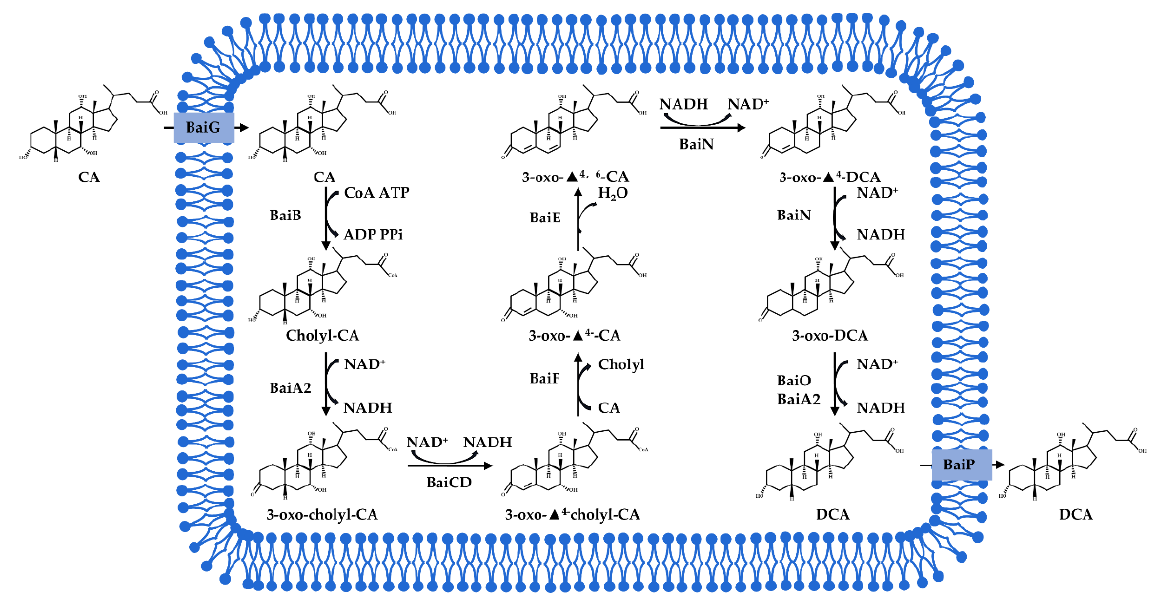
Figure 3. Biotransformation of primary bile acids by Clostridium species : Primary bile acids (CA and CDCA) are biotransformed to the secondary bile acids DCA and LCA, respectively. The processes include multiple steps catalyzed by several enzymes and bile acid transporters encoded by bile acid-inducible (BAI) genes.